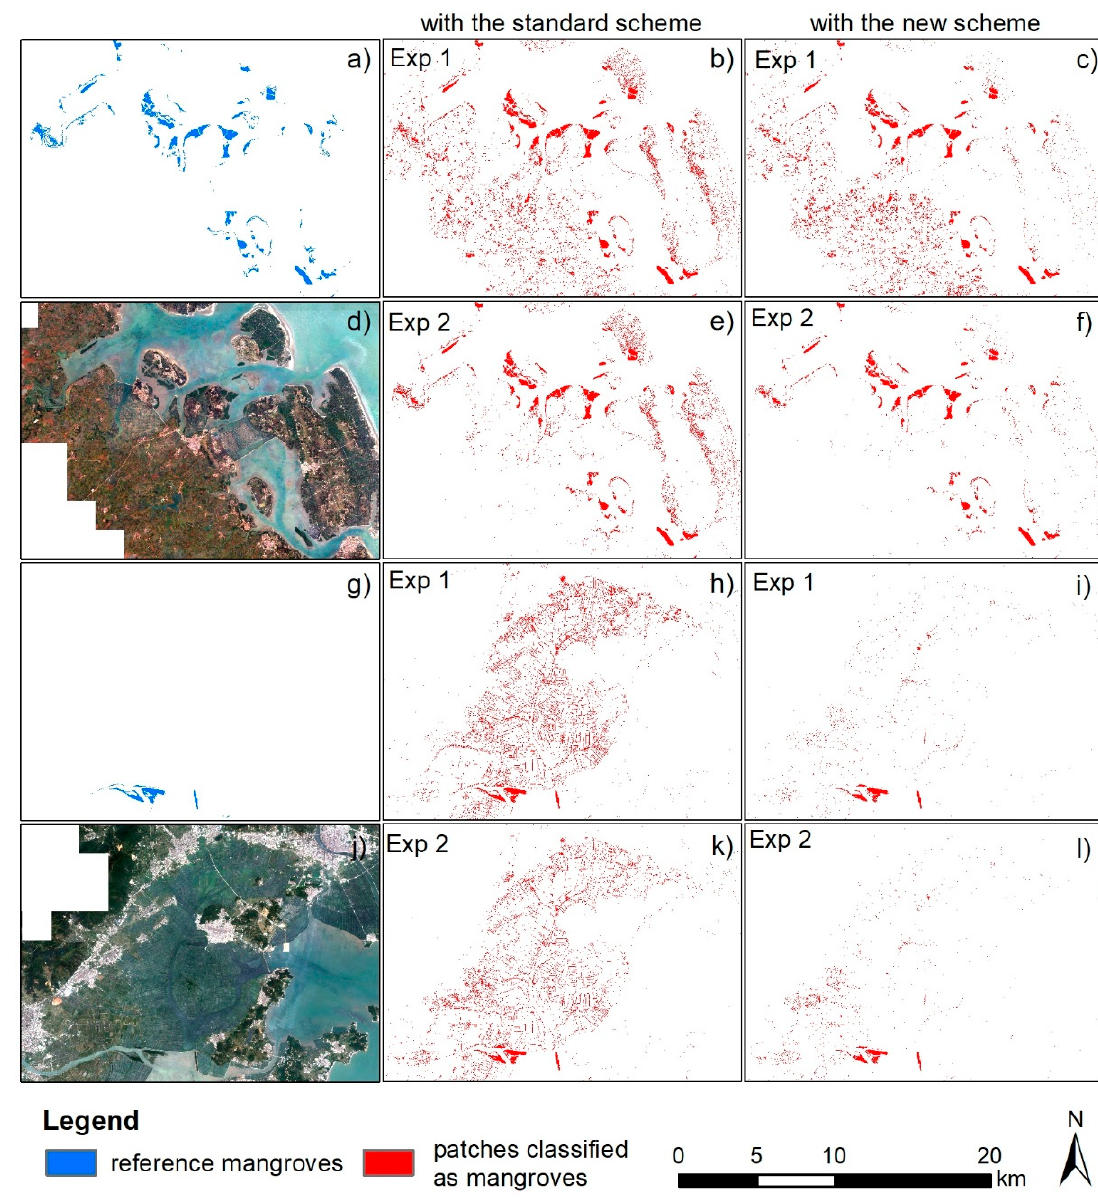
Figure 10. Classification results in the two selected subset areas in two experiments. (Exp1: the first experiment that utilized the same total features in classifications in ( b ), ( c ), ( h ), and ( i ), and Exp2: the second experiment that utilized the optimal features in classifications to balance the probability that a selected feature was effective for the scheme in ( e ), ( f ), ( k ), and ( l ). The reference map and corresponding true color composite image from Sentinel-2 for two selected subset areas are shown in left panels, that is, ( a ) and ( d ), ( g ) and ( j ), respectively. Table 6. Number of false positive pixels in the two selected subset areas in two experiments.